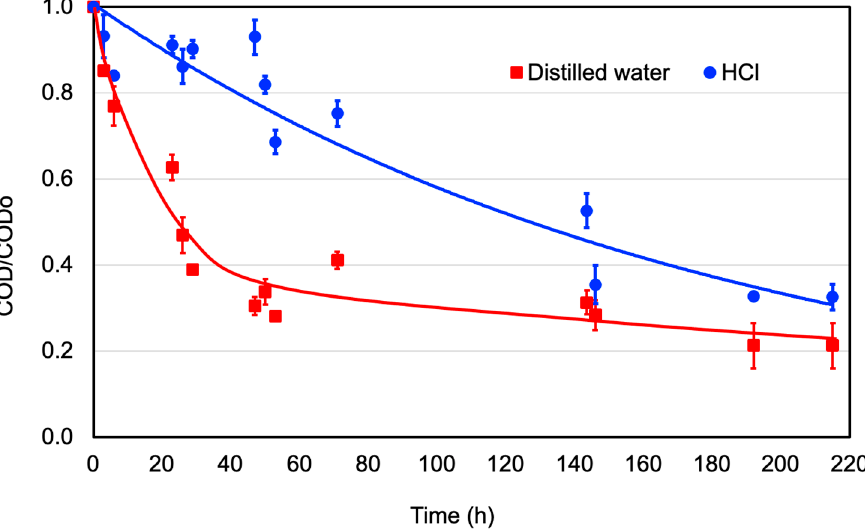
Figure 3. Degradation of organic matter when graphite electrodes are used in the MFC system. COD reduction.